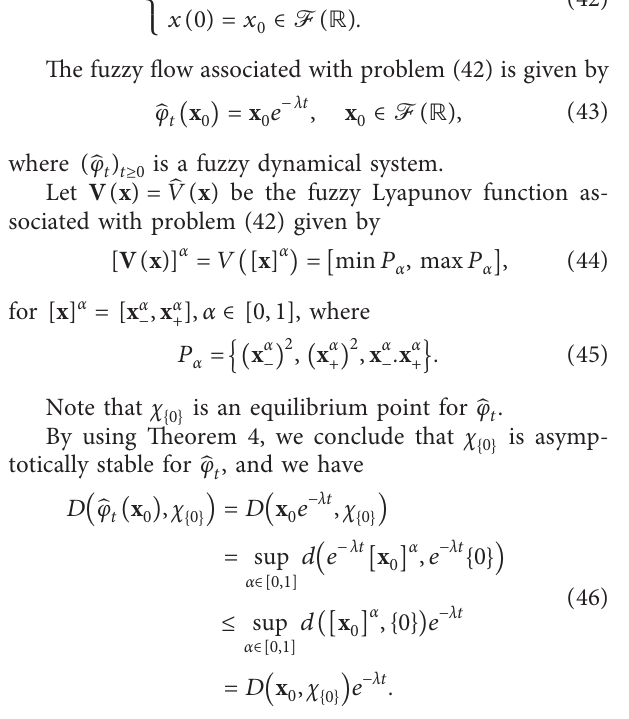
Figure 1: Dynamic of 􏽢 φ